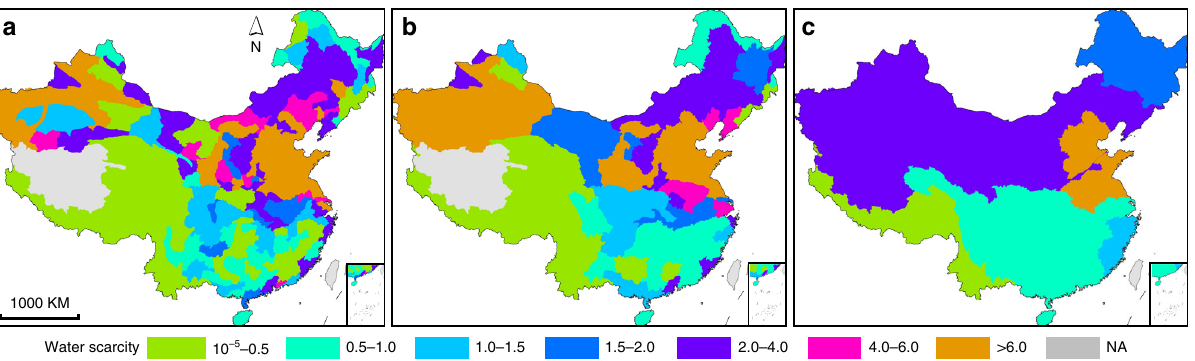
Fig. 2 Quality-included water scarcity (WScom) across river basins on an annual basis. a The third-order basin level ( n = 209). b The second-order basin level ( n = 76). c The fi rst-order basin level ( n = 10). Maps of WScom at other time scales for these three basin levels are shown in Supplementary Figs. 3 – 5. Source data are provided as a Source Data fi